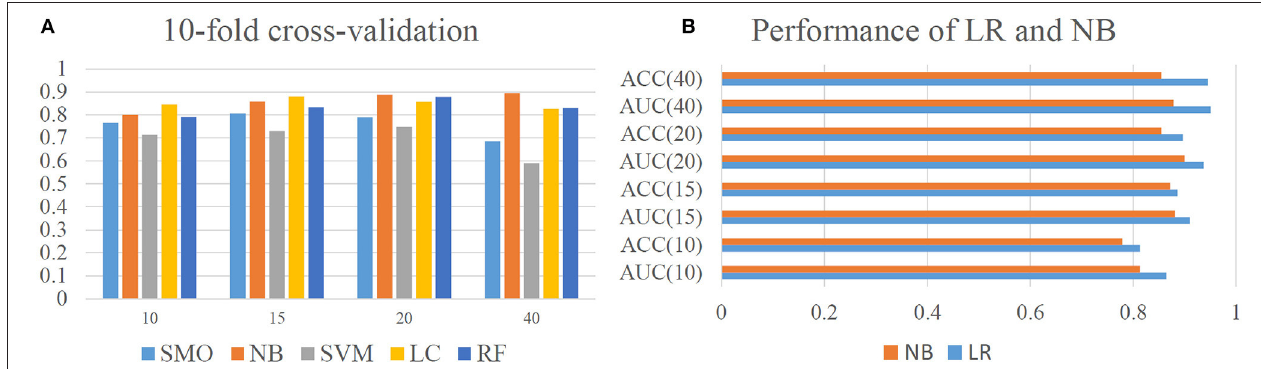
FIGURE 2 | Model performance of our model. (A) Cross-validation performance of qualitative model constructed by Sequential Minimal Optimization (SMO), Naïve Bayes (NB), Support Vector Machine (SVM), Logistic Classifier (LC), and Random Forest (RF). Here, Y axis represents the AUC-value of different computational models. (B) Performance of Linear Regression and Naïve Bayes on independent